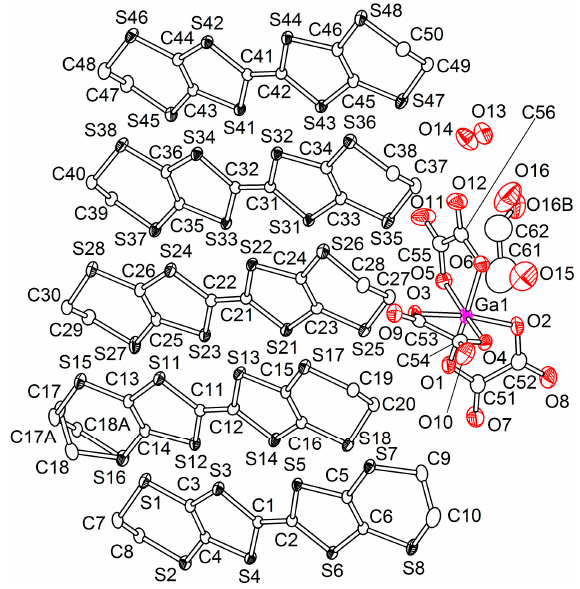
Figure 4. Asymmetric unit in 5 (50% level of thermal ellipsoids).